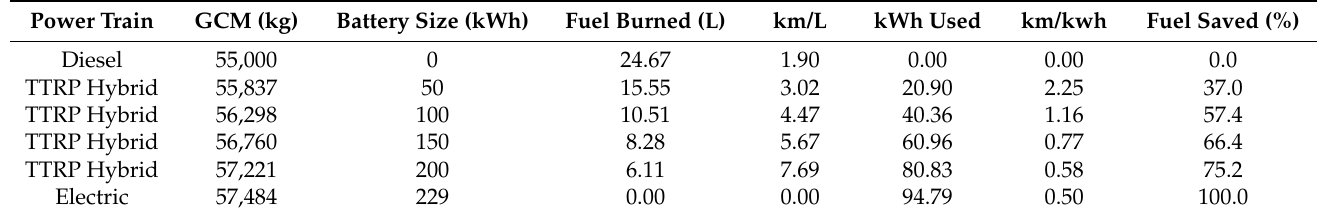
Table 8. Drive cycle 3 results.